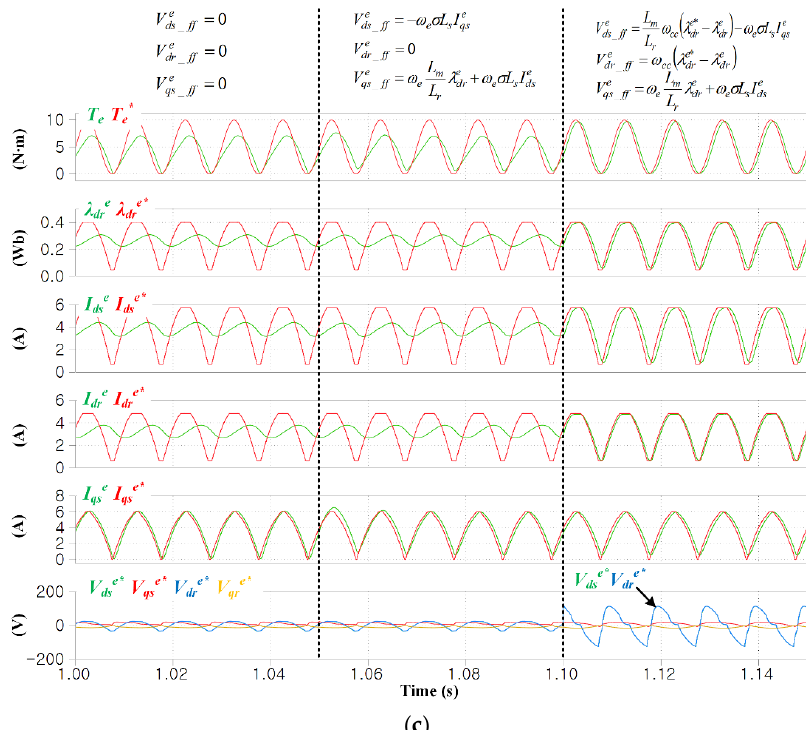
Figure 6. Simulation results for the current, rotor flux, and torque controls according to sinusoidal torque reference at a low speed (200 r/min): ( a ) 10 Hz; ( b ) 50 Hz; ( c ) 100 Hz.